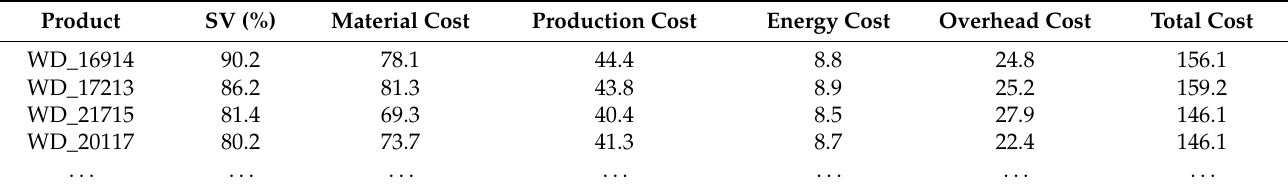
Table 2. Cost projections using an analogical